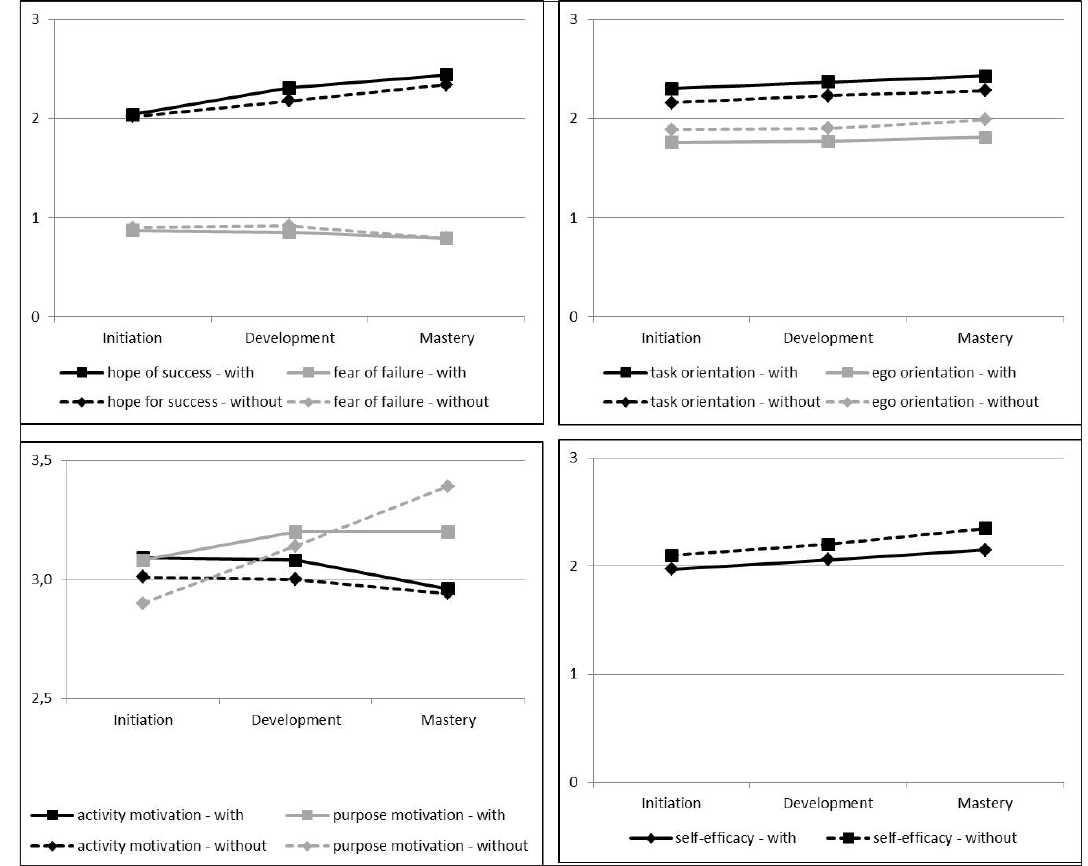
Figure 2. Development of personal factors in the course of a career for athletes with and without a disability (the exact descriptive values may be retrieved from Table